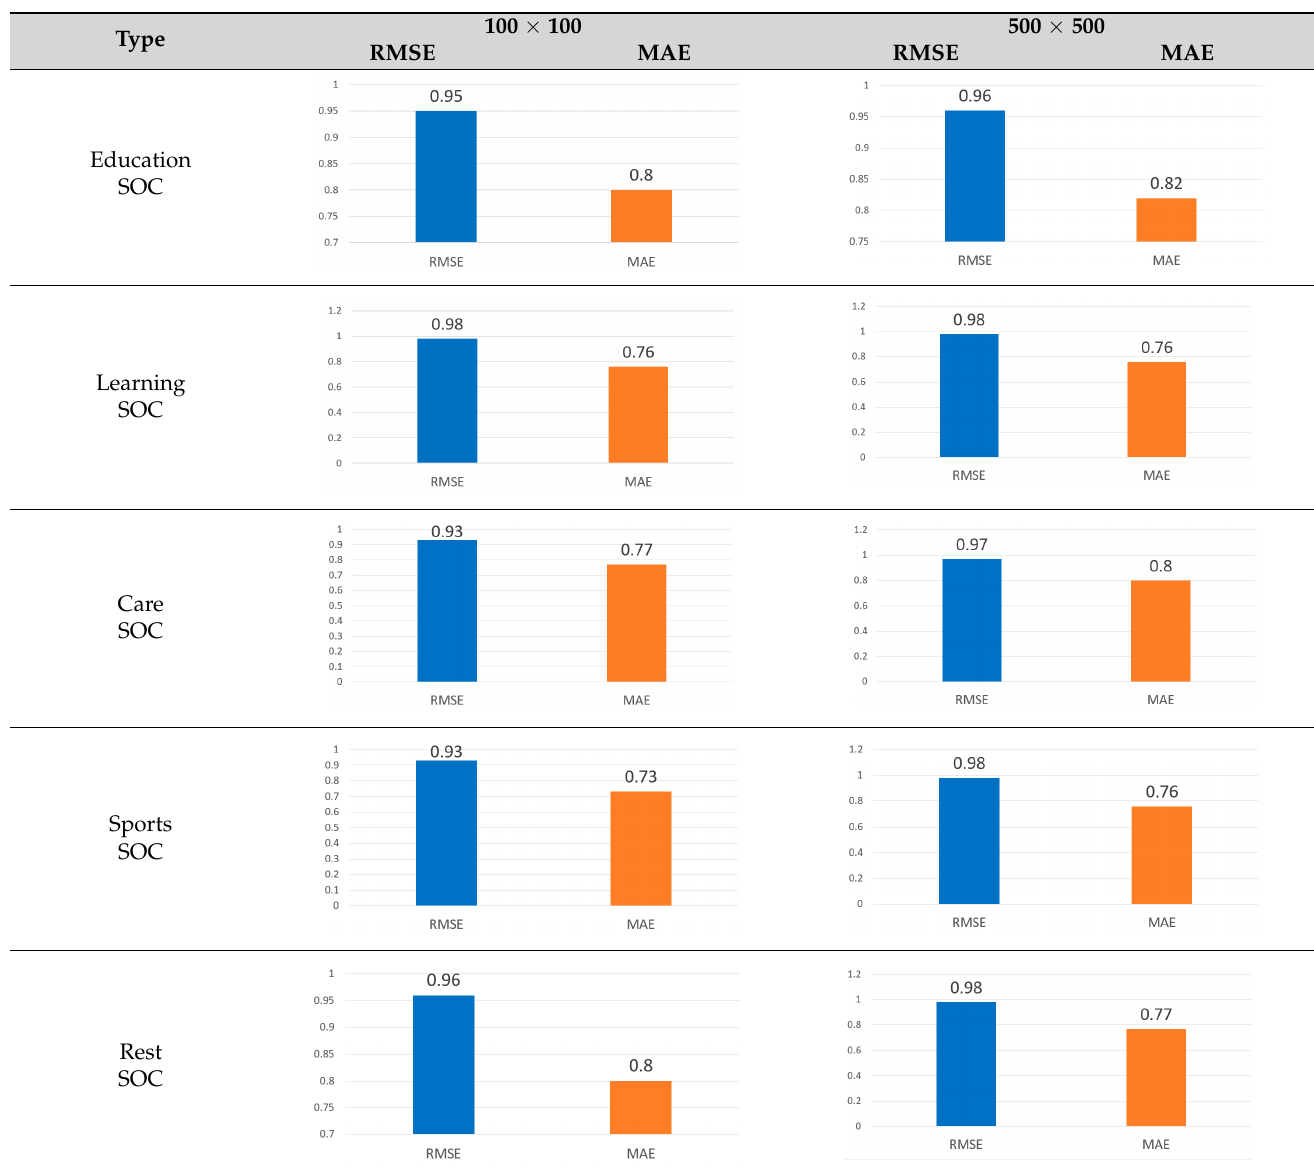
Table 8. Comparison of the data model results.